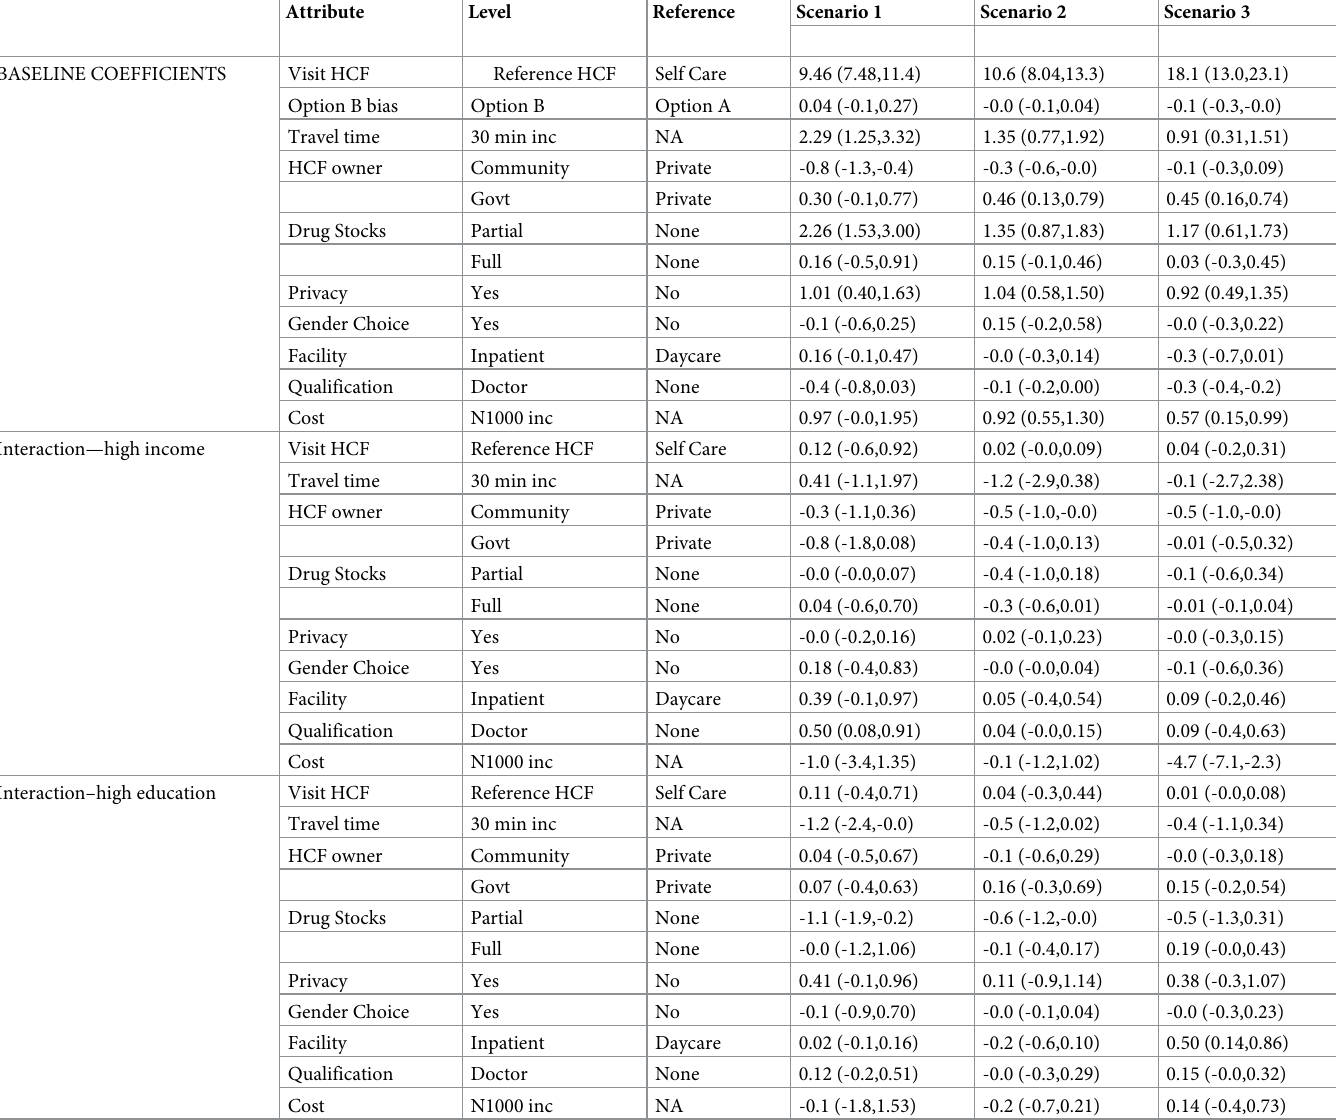
Table 8. Mixed logit model with interactions results for each